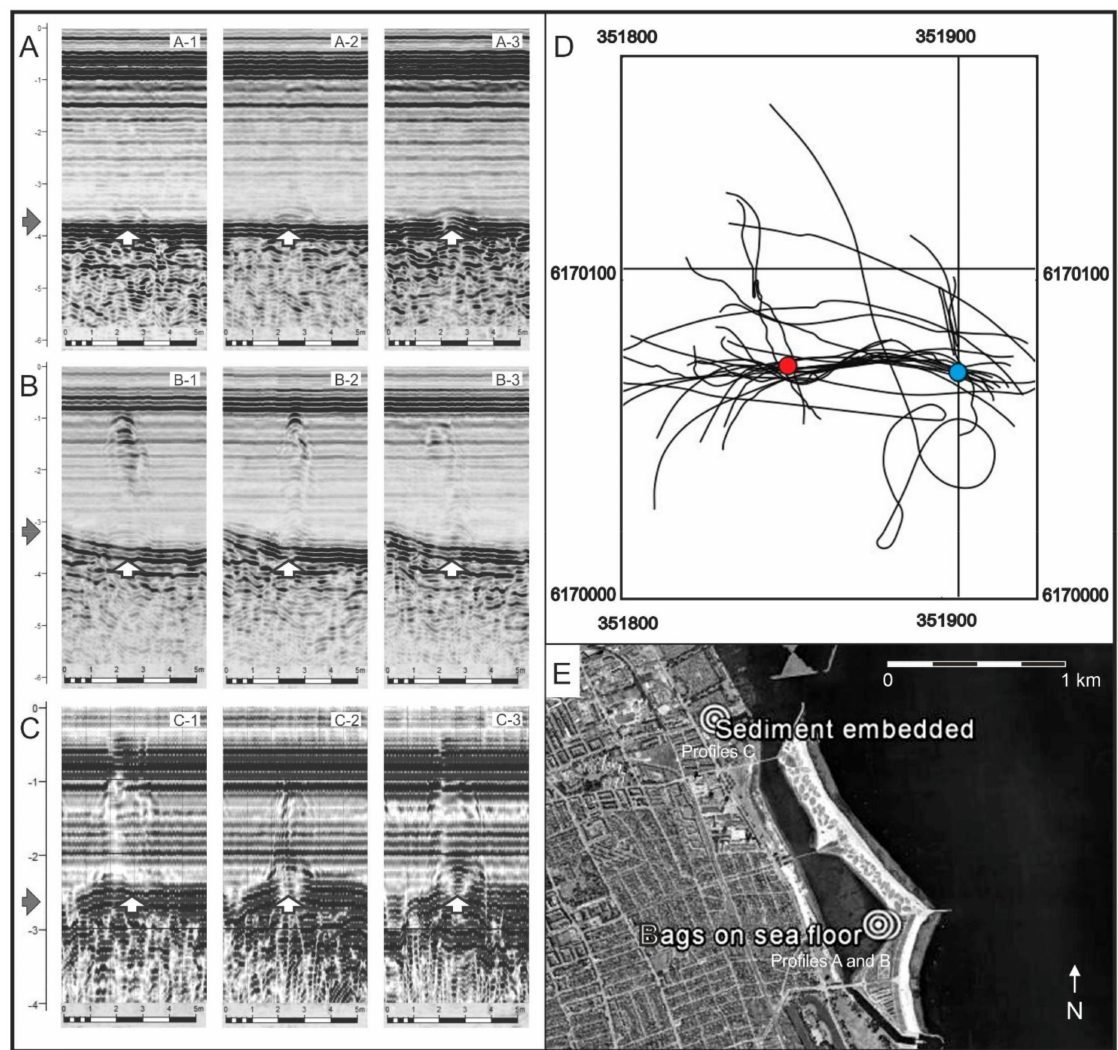
Figure 7. ( A – C ) Acoustic profiles recorded during resonance experiments. The grey arrows in panels ( A – C ) indicates the level of the seafloor. Cloth bags containing naturally cracked flint pieces ( A ), knapped flint pieces ( B ) and a bucket containing sand with embedded knapped flint pieces ( C ) are marked with white arrows and can be discerned on the seafloor. ( A1 – A3 ) Experiment 1: 14 kg of naturally cracked flint in a cloth bag. No flint response is evident in the water column. ( B1 – B3 ) Experiment 2: 14 kg of knapped flint in a cloth bag. A clear acoustic flint response can be observed in the water column. ( C1 – C3 ) Experiment 3: 14 kg of knapped flint embedded in sediment in a plastic bucket. A clear acoustic flint response is evident in the water column. ( D ) The sailing lines for experiments 1 and 2. The blue dot marks the bag containing human-knapped flint debitage and the red dot marks naturally cracked flint. ( E ) Location of experiments in the southern part of the lagoon of Amager Strandpark, Denmark. Experiment 3 was located in Sundby Sailing Union’s small harbour, north of the lagoon [41]. Zone 33 UTM coordinates. Graphic: